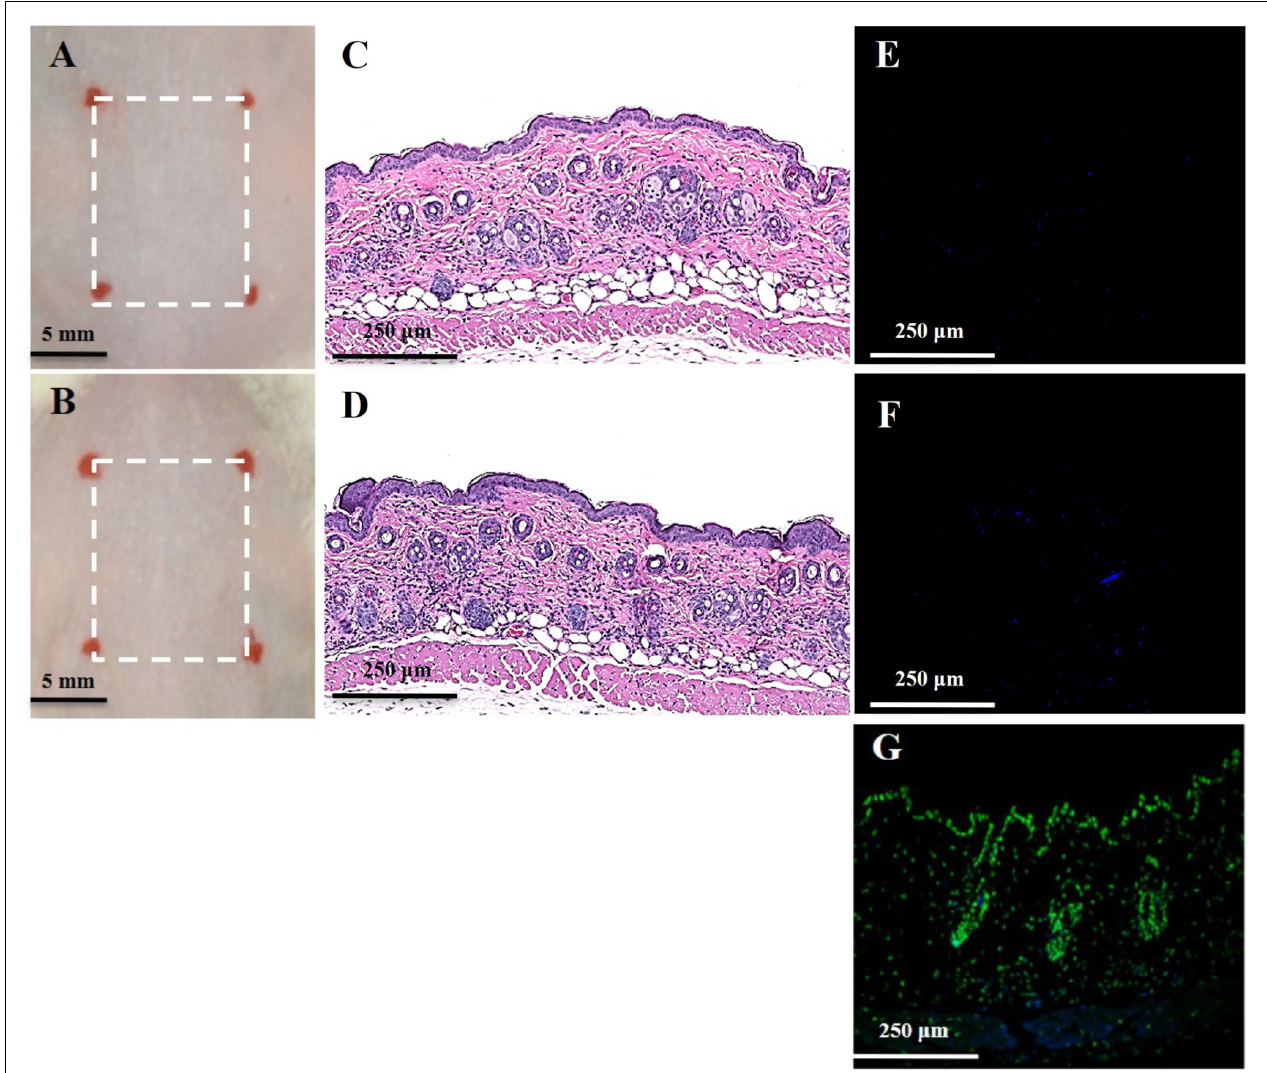
FIGURE 6 | Toxicity evaluation of oregano oil to normal mouse skins. The dorsal skin of mice was topically treated with (A,C,E) or without 10 mg/ml oregano oil (B,D,F) once a day for three consecutive days. On day 4, the skins were photographed (A,B) , followed by histological examination (C,D) . The skin sections were also TUNEL stained (E,F) . DNase I treated skin samples (G) were TUNEL stained in parallel as positive-staining